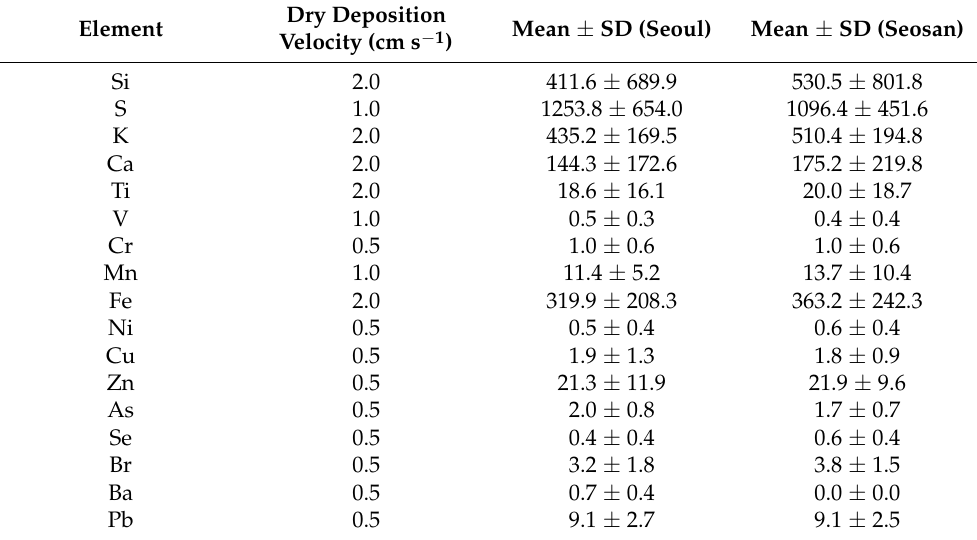
Table 3. Average dry deposition flux ( µ g m − 2 d − 1 ) for PM 2.5 -bound elements in Seoul and Seosan during the winter